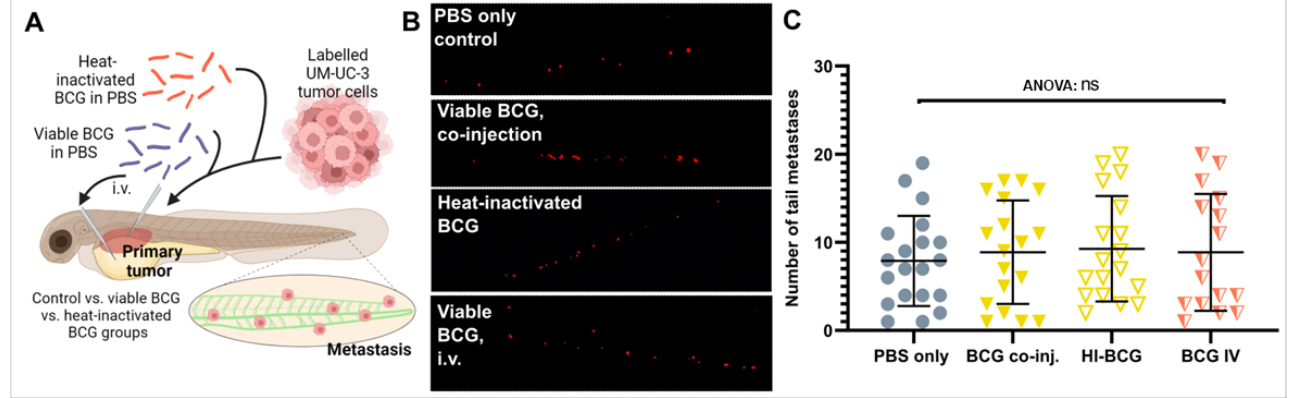
Figure 4. Tumor dissemination is not significantly impacted by BCG treatment of zebrafish UM-UC-3 tumor xenografts. ( A ) Cartoon showing the outline of the experiment. Fluorescently labelled UM-UC-3 tumor cells alone or mixed with viable or heat-inactivated BCG were injected into the PVS of 48 h old zebrafish larvae. Alternatively, viable BCG was injected intravenously in subcutaneous tumor-bearing larvae. ( B ) Fluorescent micrographs of the caudal hematopoietic plexus of control and BCG- (co-)injected tumor-bearing larva at 3 days post-implantation. Red dots represent disseminated tumor cells. ( C ) Graph showing the quantified number of cells present in the caudal hematopoietic plexus in the different treatment groups. n = 24 injected embryos per group; ns = not significant.